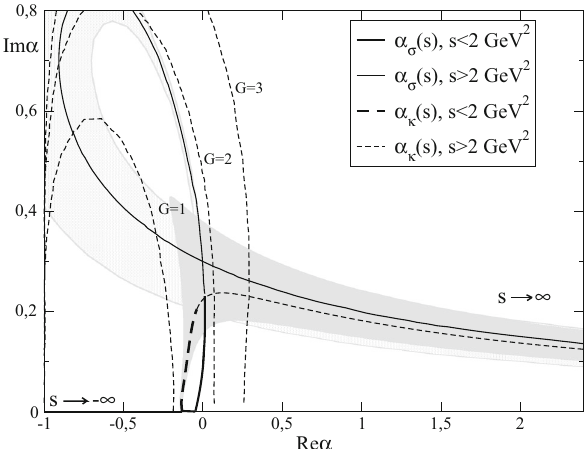
Fig. 5 At low and intermediate energies ( thick lines ), the trajectories of σ and κ are similar to those of Yukawa potentials [39–41] V ( r ) = Ga exp ( − r / a )/ r ( thin dashed lines labeled with different values of G ). Beyond 2 GeV 2 , we plot our results as thin lines because they should be considered just as